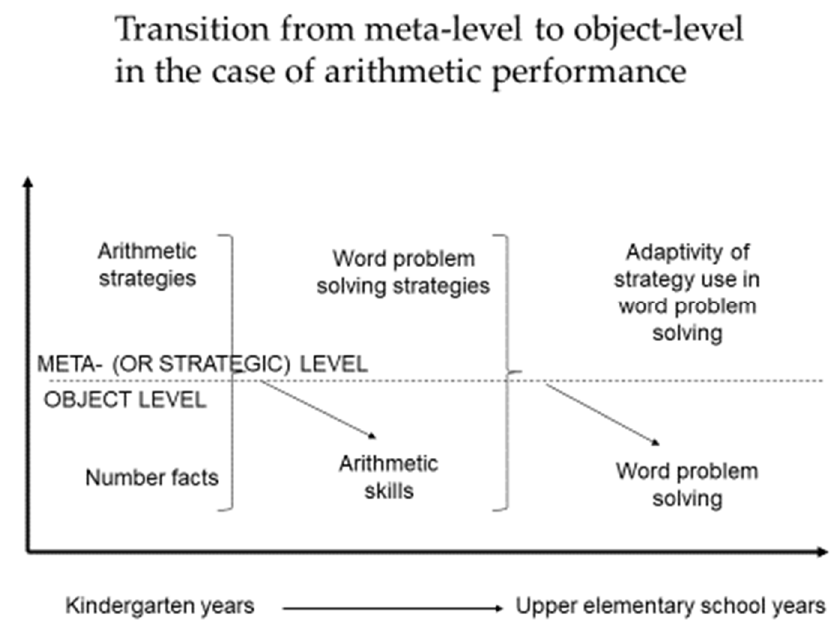
Figure 1. A tentative model of the development of arithmetic performance in the light of the Nelson– Narens model of metacognition.